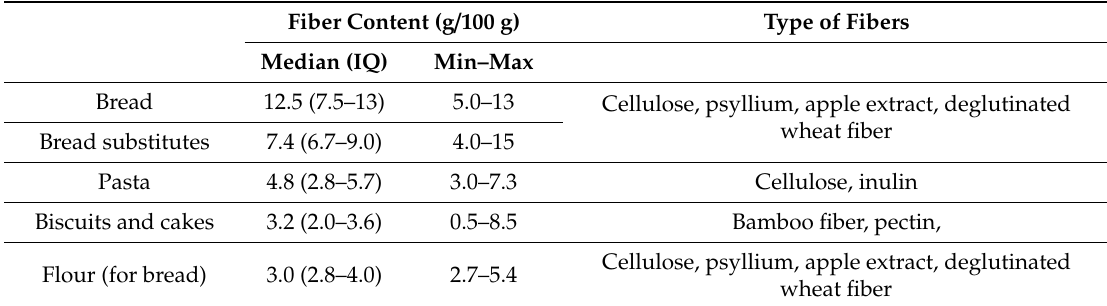
Table 4. The fiber content of the main categories of protein-free foods made by five of the most known brands of protein-free products. The data refer to 100 g of edible